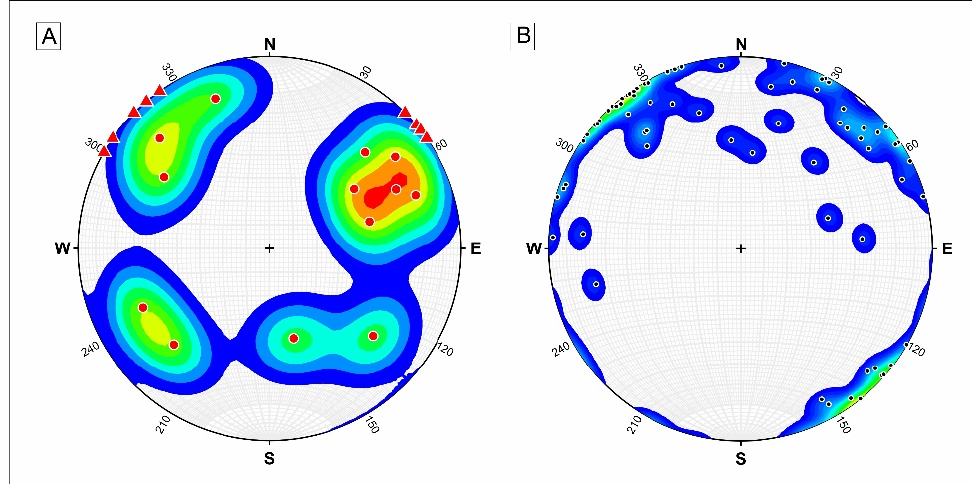
Figure 10. Stereonets of the main rock discontinuities observed in the Chgega Mountain (pole faults in circle and joints in triangle). The diagrams were elaborated on the basis of field measurements ( A ) and virtual measurements using a compass ( B ).